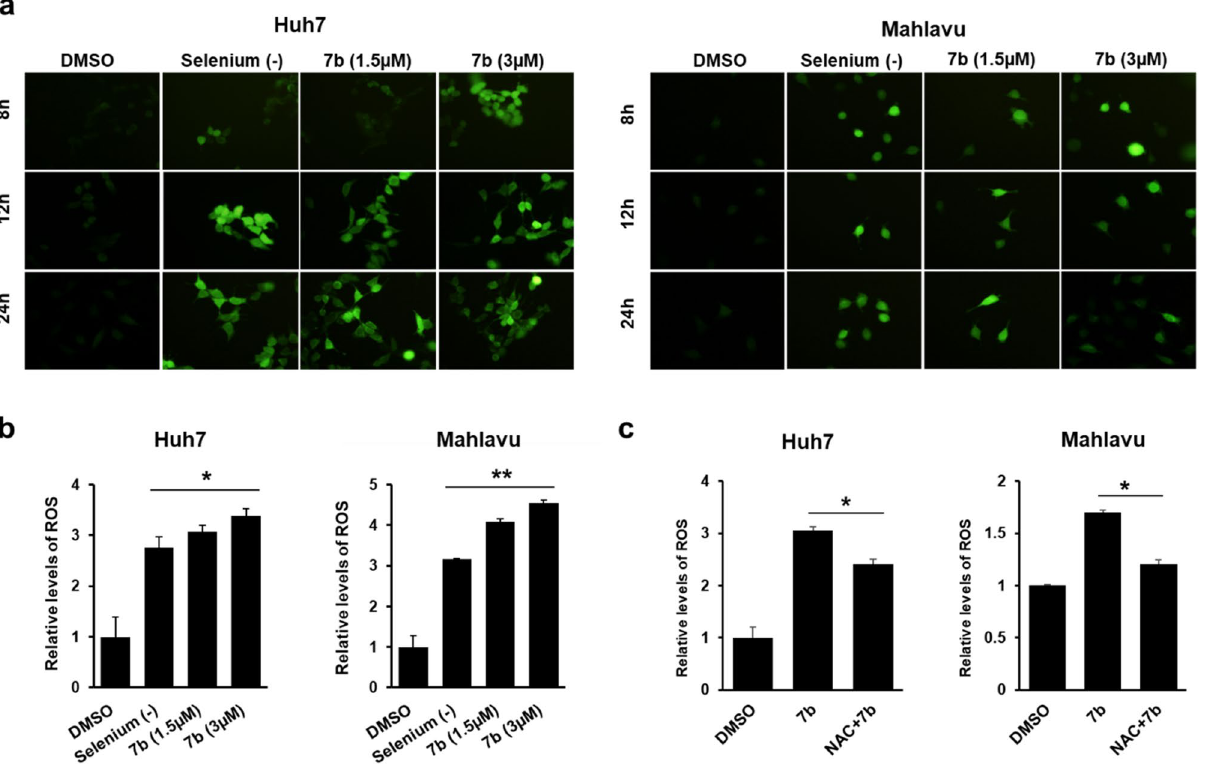
Figure 4. 7b induces oxidative stress in HCC cell lines. ( a ) Representative images of DCFH-DA staining of Huh7 and Mahlavu cells treated with Se-deficient media or increasing concentrations of 7b for 8, 12, and 24 h. All images are obtained under a fluorescent microscope with 20 × magnification. ( b ) Flow cytometric analysis of ROS accumulation in HCC cells. Bar graphs indicate the fold change and quantitative analysis of ROS-positive cells relative to DMSO after 12 h for each treatment condition. Se-deficient medium was used as a positive control for ROS induction. ( c ) Quantitative analysis of reversal of ROS induction upon NAC pretreatment in HCC cells is represented in bar graphs. Cells were either treated with 3 µM 7b only or 5 mM NAC for 1 h and then with 7b for 12 h. ROS accumulation in HCC cells was analyzed using flow